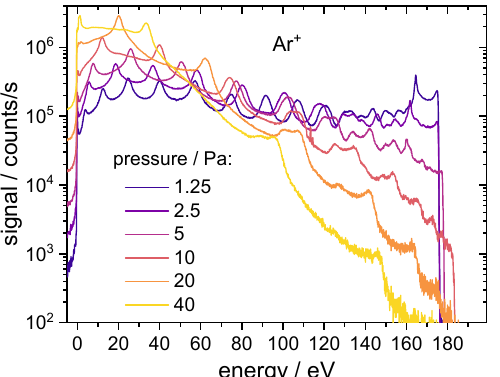
Figure 4. Dependence of the measured Ar + IEDFs on the chamber pressure. Applied voltage 300V pp